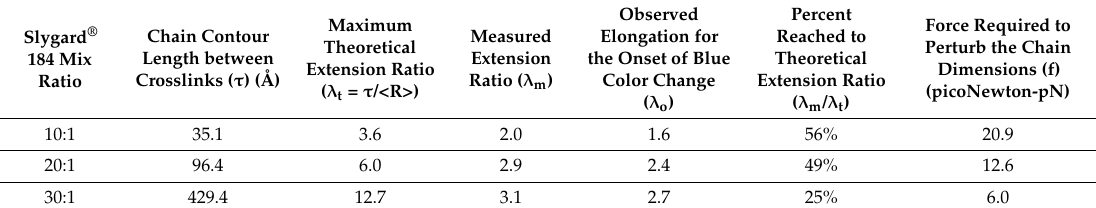
Table 2. The effect of network structure on color change and network stretchability.